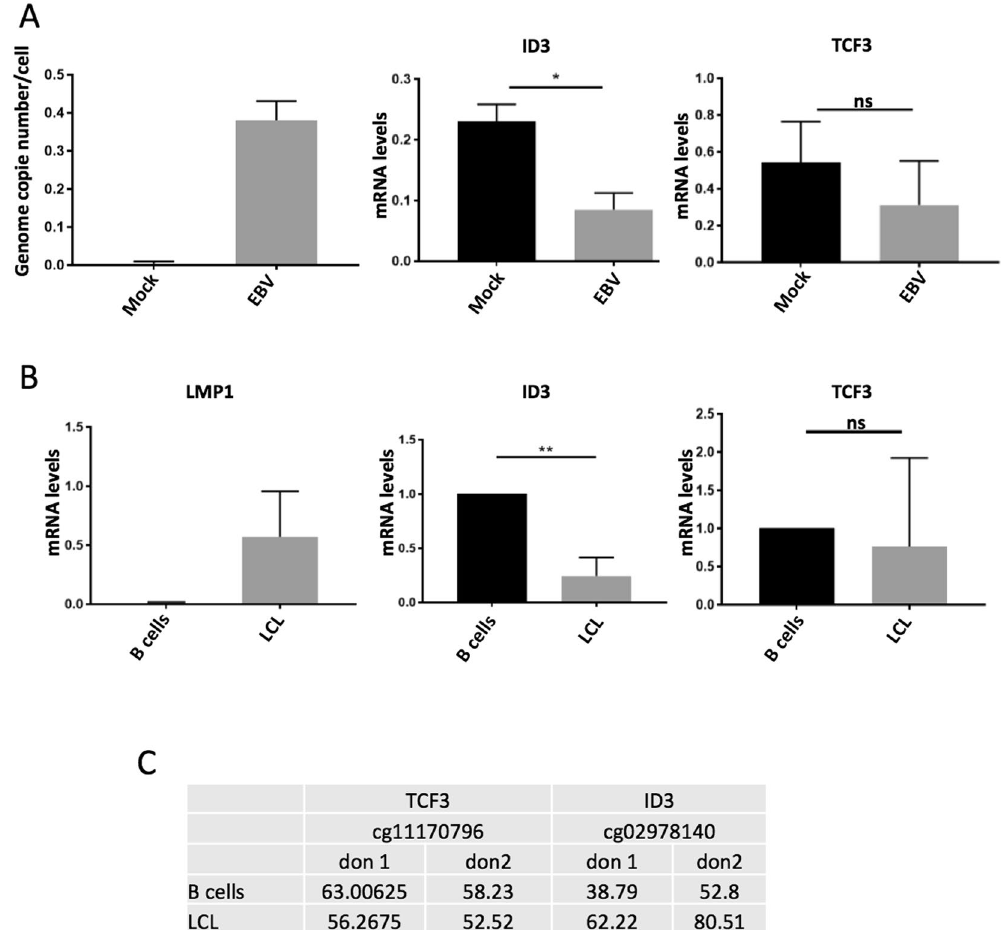
Figure 5. EBV-dependent silencing of ID3 expression in vitro . ( A ) Loucks cells were infected with EBV or mock infected for 48 h, then collected and processed for RNA/DNA extraction. 100ng of DNA were analysed by Taqman PCR for the EBV genome copy number (right panel). Total RNA was retro-transcribed and cDNA analysed by qPCR for the levels of ID3 and TCF3 (central and left panel). The histograms show the average results of two independent infections ( * p value < 0.05; ns = non-significant). ( B ) Primary B cells from three different donors were putted in culture for 24–36 h, after that cells were in part collected to make dry pellets and in part infected with EBV and cultured until they got immortalized (LCL). Nucleic acids were extracted from primary and immortalized cells, total RNA retro-transcribed and analyzed by qPCR for the levels of the indicated genes. Histograms show the average mRNA levels for the indicated genes, measured in B cells and in the corresponding LCL from three independent donors ( ** p value < 0.01; ns = non-significant). ( C ) DNA from primary and immortalized matched samples from 2 donors were processed for pyrosequencing and analysed for the levels of methylation of the cg02978140 and cg11170796